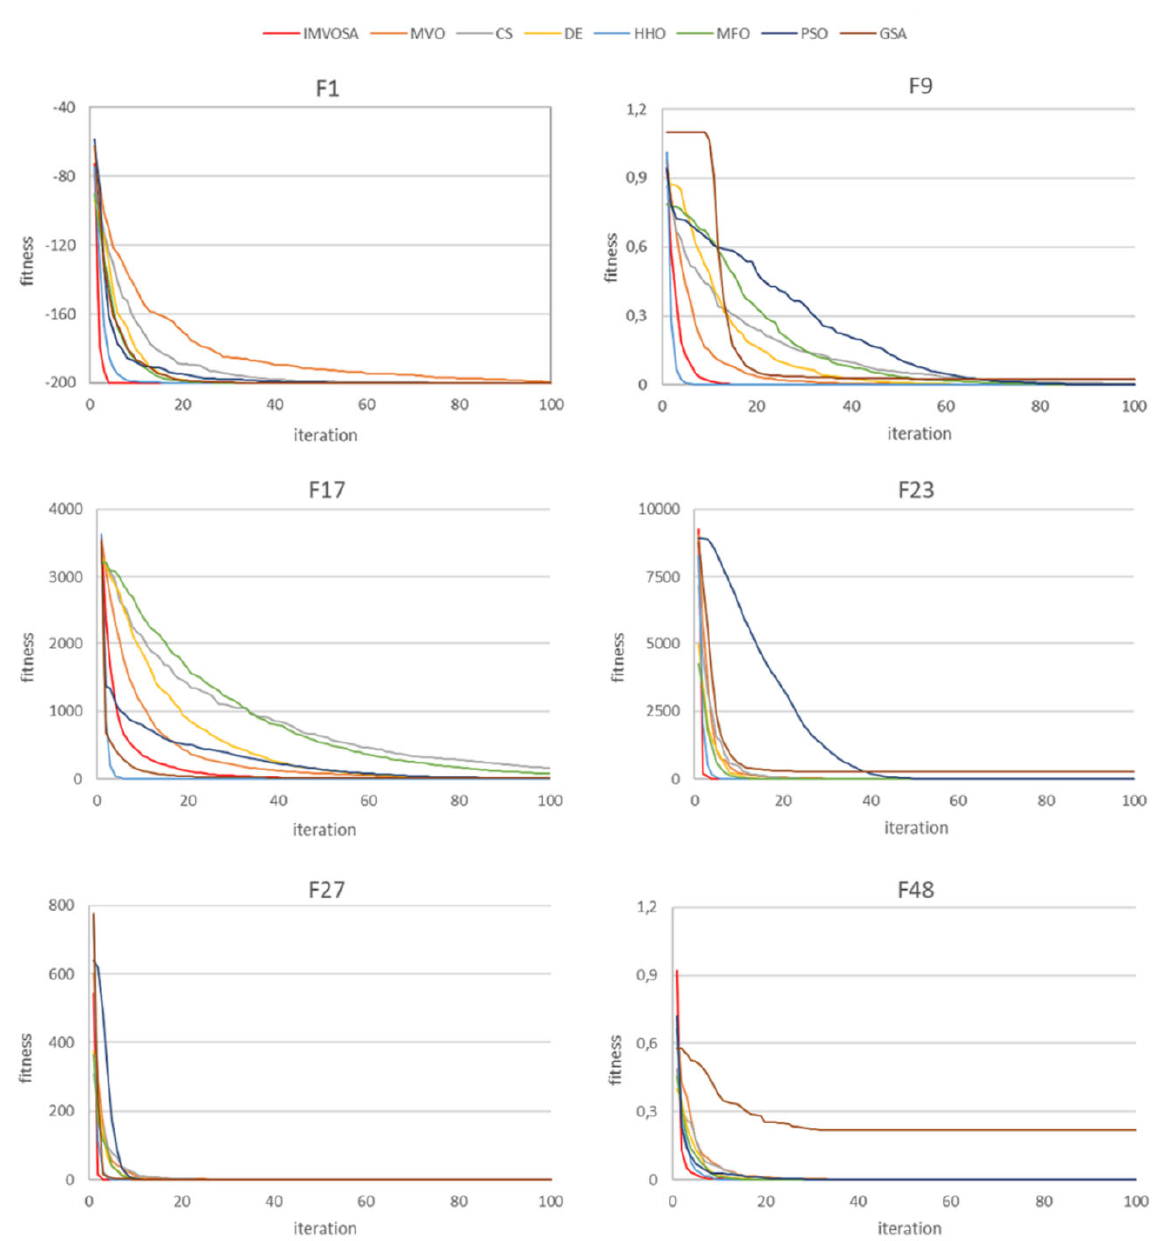
Fig. 2. Convergence curves of six benchmark functions (F1, F9, F17, F23, F27,